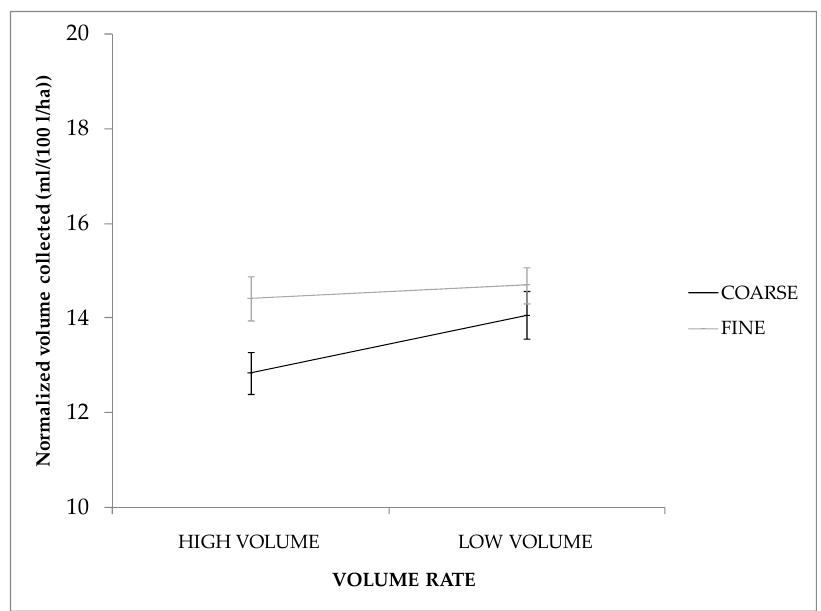
Figure 23. Nozzle type × Volume rate interaction effect on the normalized volume collected in the canopy zone (mean ± SE) with the C2 sprayer.